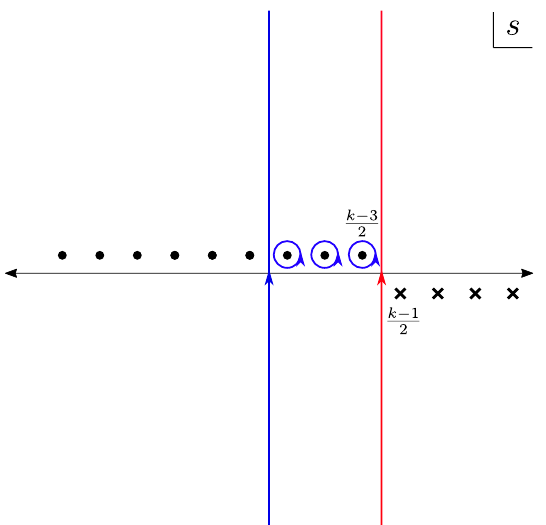
(cid:0) k − 1 (cid:1) Γ (cid:0) 3 − k + s (cid:1) offset from the real − s 2 2 (crosses) and 2 (dots). It is therefore the Mellin-Barnes contour 2 (cid:1) Γ (cid:0) 1 + s (cid:1) . The blue contour therefore − s 2 2